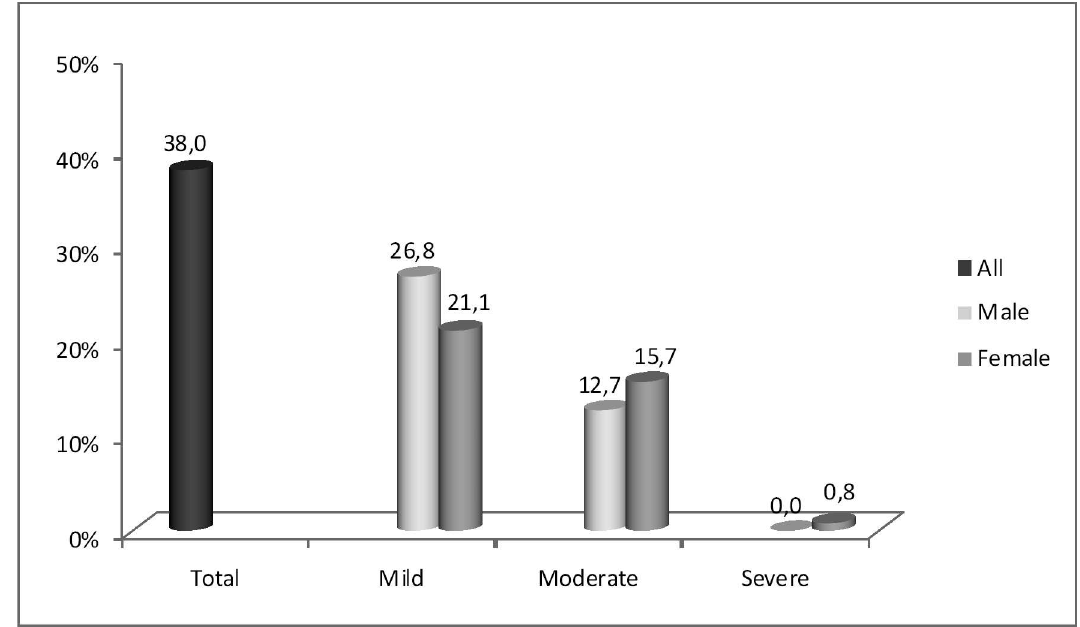
Fig 1. Total prevalence and degrees of anemia according to gender in the institutionalized elderly in Salvador, Bahia, Brazil.